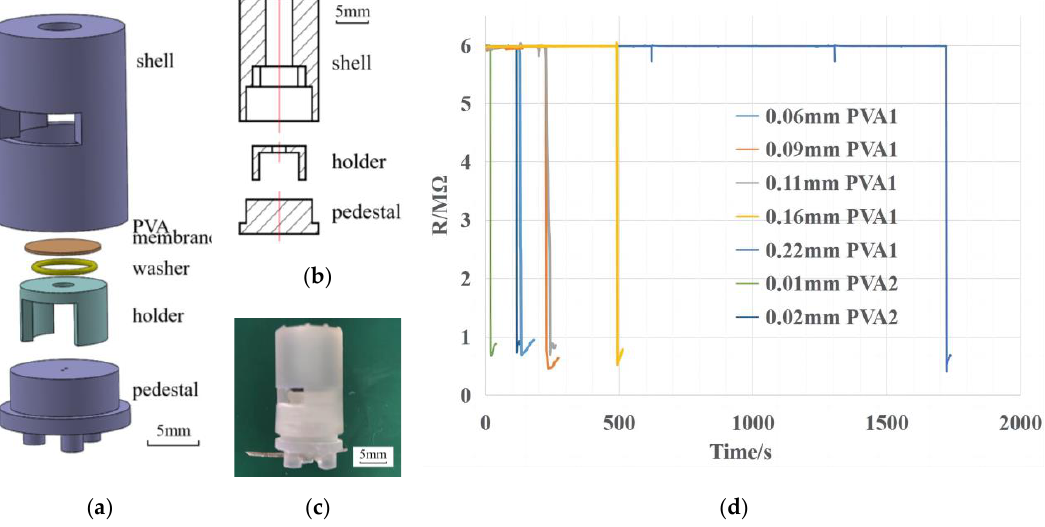
Figure 2. ( a ) Exploded view of the device to measure the dissolution time of PVA membranes. ( b ) Cross-sectional view of the device. ( c ) Photograph of the device. ( d ) Resistance curve of different kinds of membranes with time.